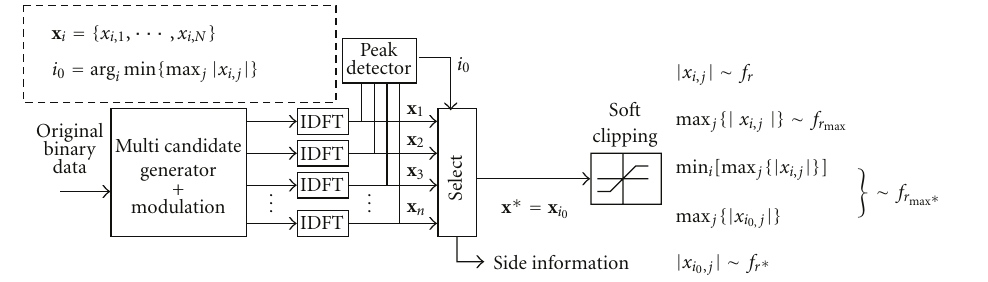
Figure 1: Multiple candidate system and its PDF notation for several variables. We define r i , j (cid:2) | x i , j | , and the peak detector selects the i 0 th (max j { r i , j } ) for i ∈ { 1, ... , n } and j ∈ { 1, ... , N } candidate, where i 0 = argmin i